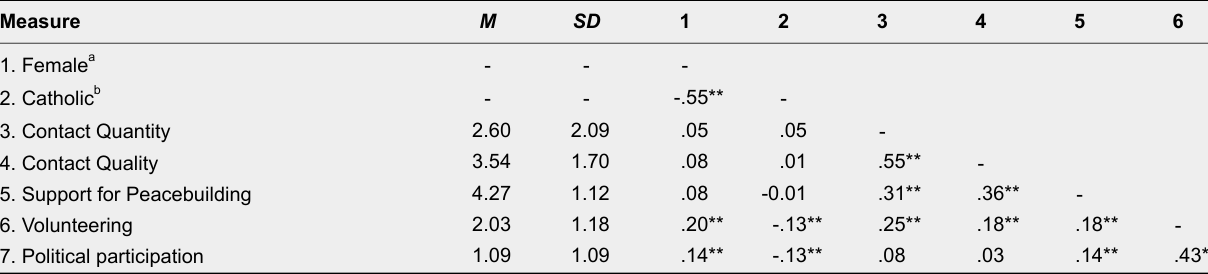
Means, Standard Deviations and Bivariate Correlations for All Manifest Study